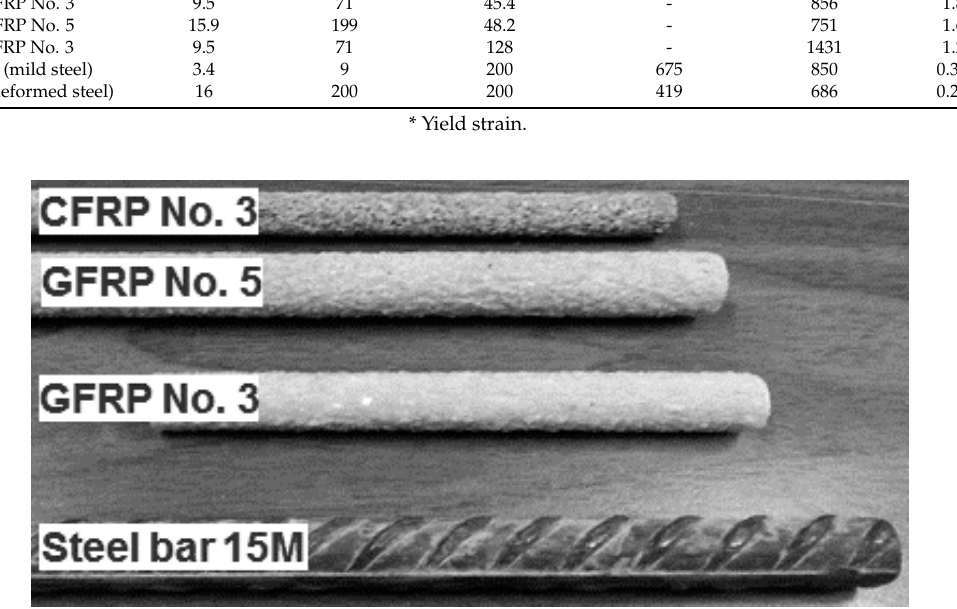
Figure 3. Filament wound glass fiber-reinforced polymer (GFRP) tubes.